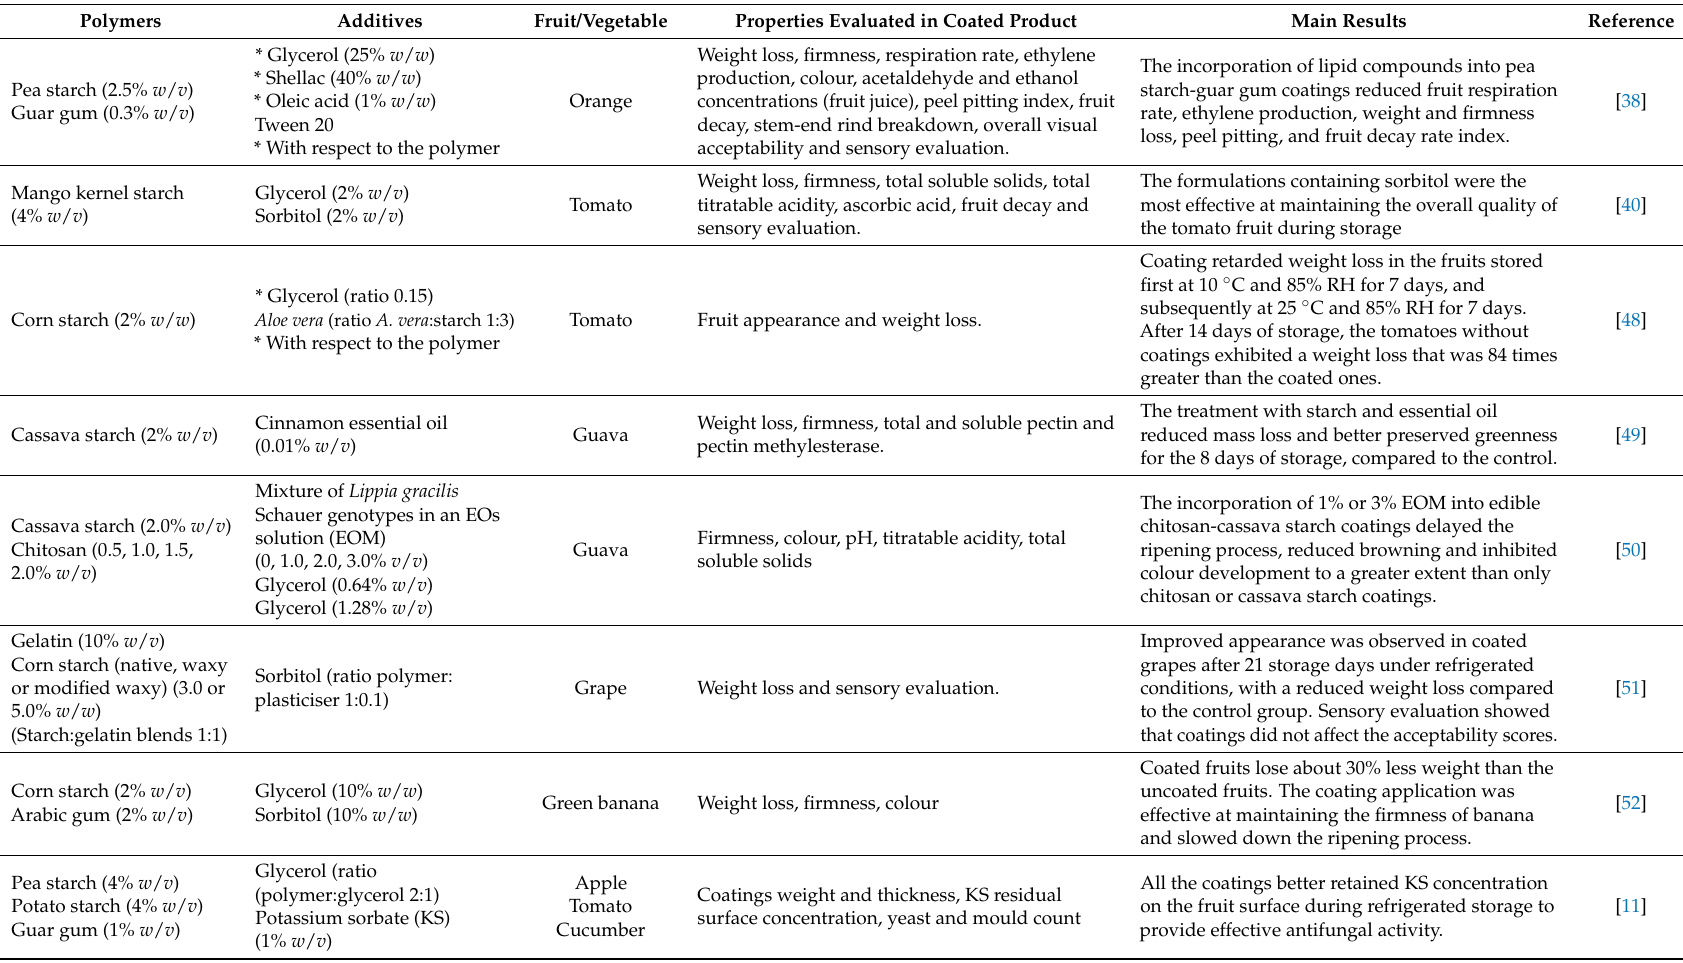
Table 3. Starch-based coatings applied to fruits and vegetables (polymer and additives concentration in the coating-forming dispersion, except when indicated with respect to the total